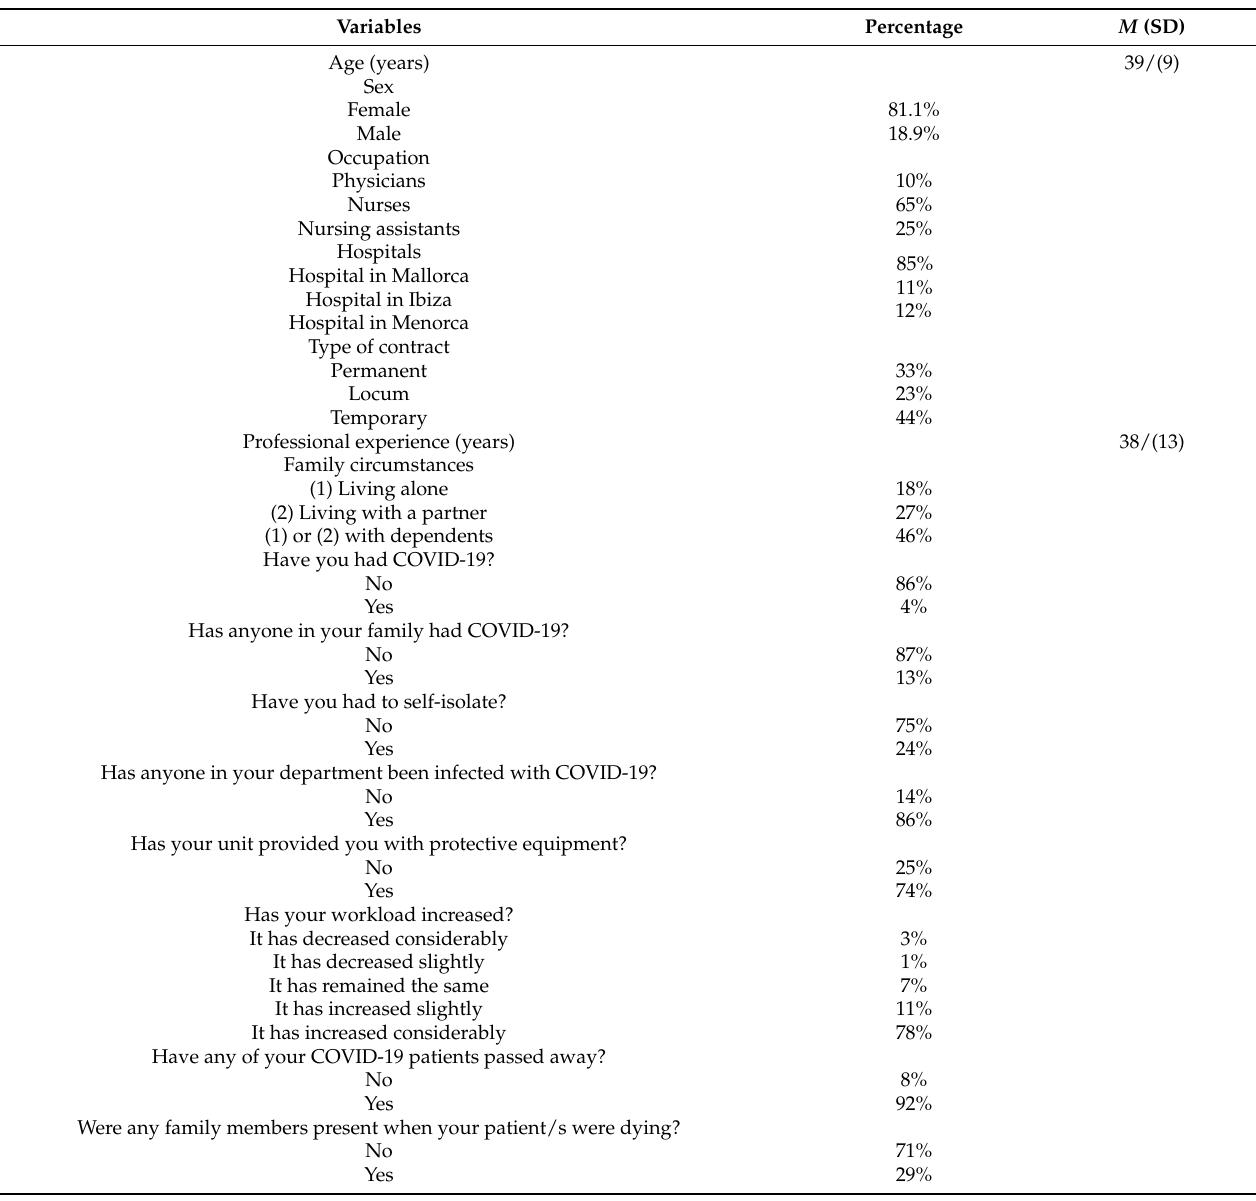
Table 1. Characteristics of the participants ( n =